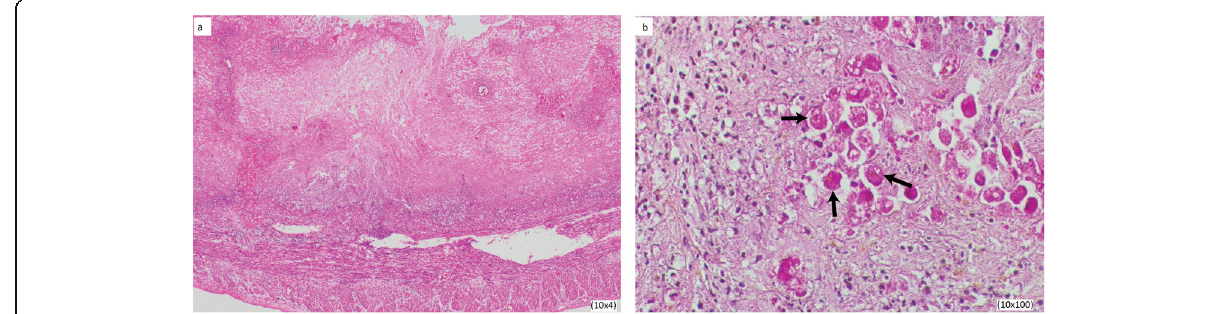
Fig. 2 Histopathological images showing a typical amebic flask-shaped ulcer (10 × 4) and b PAS-Martius Yellow 40-stained section of the infected colonic mucosa (10 × 100). Arrows indicate the erythrophagocytic